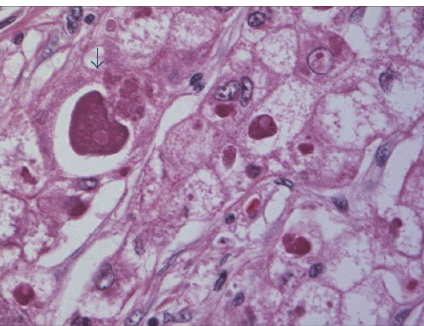
Figure 3: This photograph shows hyaline and Mallory-Denk bodies within the same inclusion